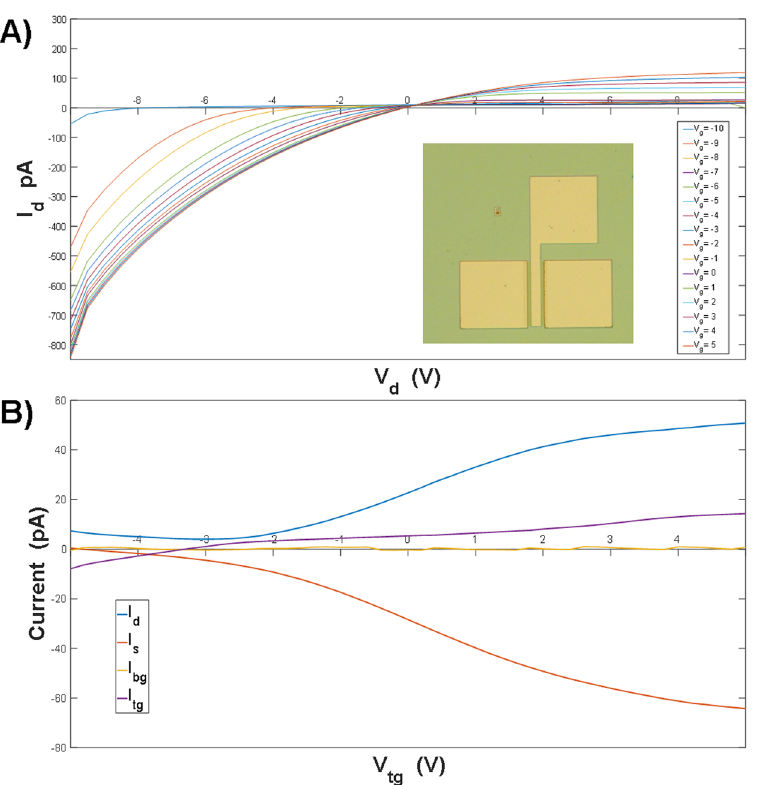
Figure 9. Drain current-drain voltage ( A ) and transconductance ( B ) characteristics for top-gated MoS 2 field effect